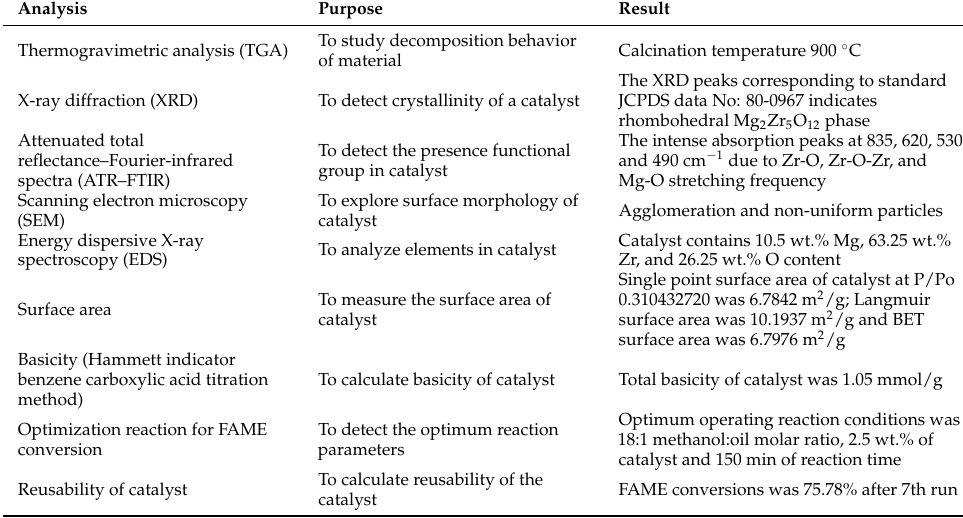
Table 1. Summarized characterization of Mg 2 Zr 5 O 12 catalyst